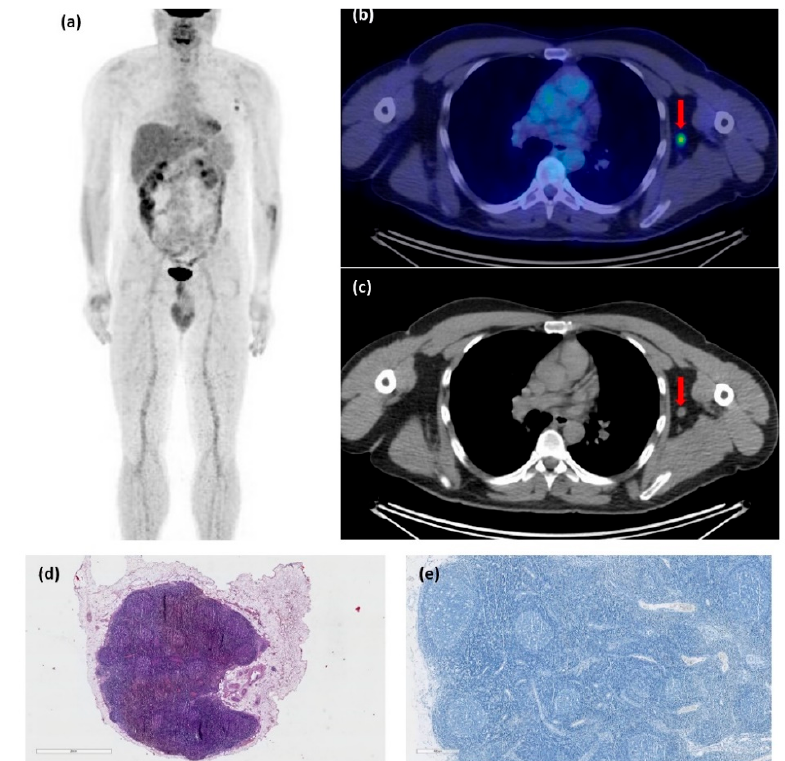
Figure 4. 48-year-old male patient, diagnosed with malignant melanoma, pT3b pN0, follow-up scan. Image ( a ) shows the maximum intensity projection of the patient’s scan. Images ( b , c ) show a metabolically active axillary lymph node, on the same side as the mRNA vaccine, taken one week prior to the PET-CT examination, raising the suspicion of disease progression (marked with an arrow). A biopsy was performed, showing reactive changes in the lymphatic tissue (Hematoxylin and Eosin staining ( d ) and Melan-A immunostaining ( e